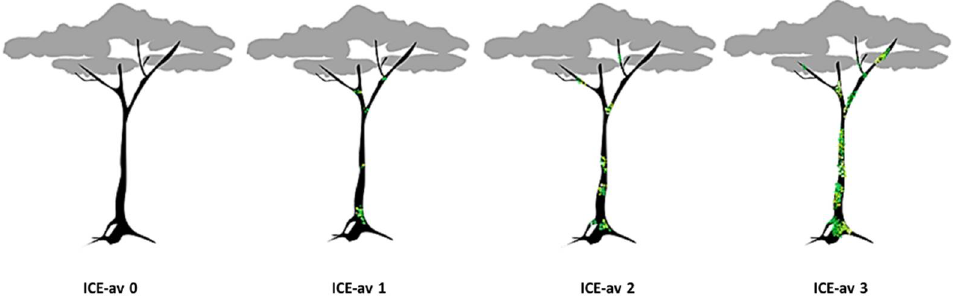
Figure 1. Schematic representation of the four classes of the Non-vascular Epiphyte Coverage Index (ICE-av). Index